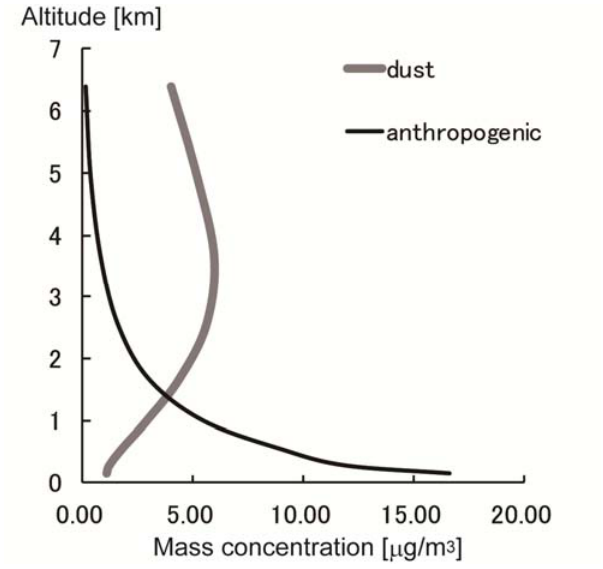
Figure 7. Simulated vertical profiles of mean aerosol total mass concentration around Osaka in spring, i.e. , March, April and May. The altitude represents above sea